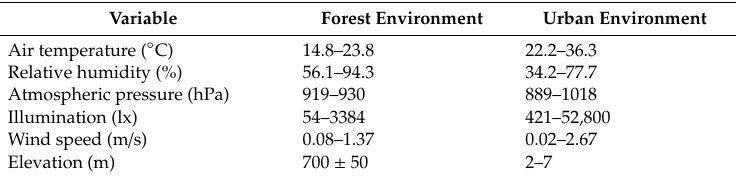
Table 2. Physical characteristics of the forest and urban environment.